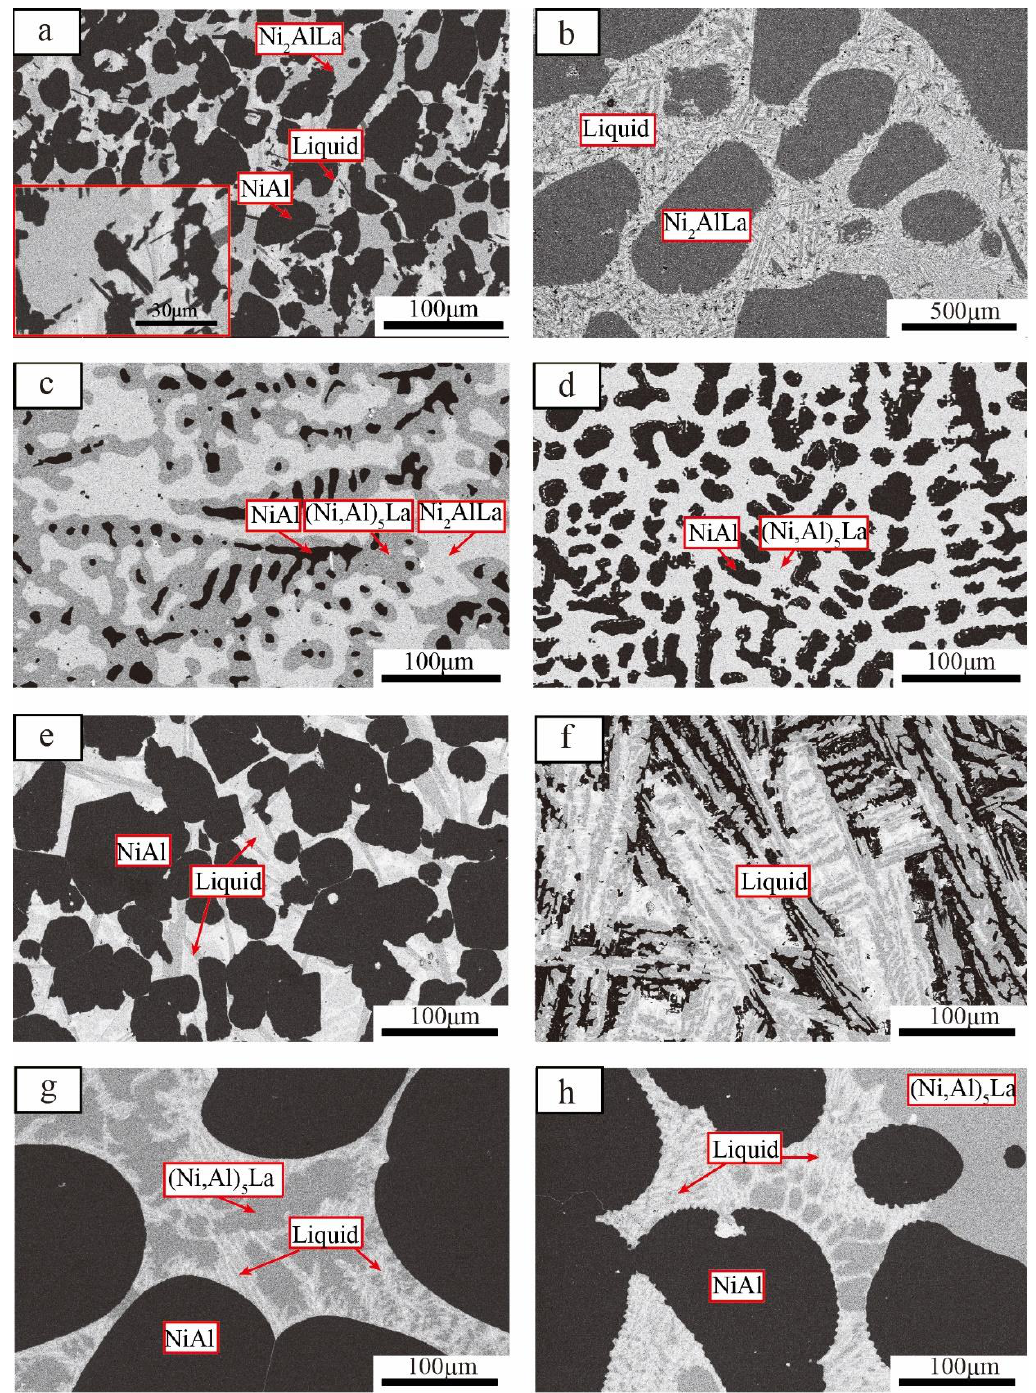
Figure 2. BSE images of ternary alloys annealed at 800 °C for 30 days: ( a ) #1 alloy, ( b ) #2 alloy, ( c ) #3 alloy, ( d ) #4 alloy. BSE images of ternary alloys annealed at 1000 °C for 15 days: ( e ) #1 alloy, ( f ) #2 alloy, ( g ) #3 alloy, ( h ) #4 alloy.